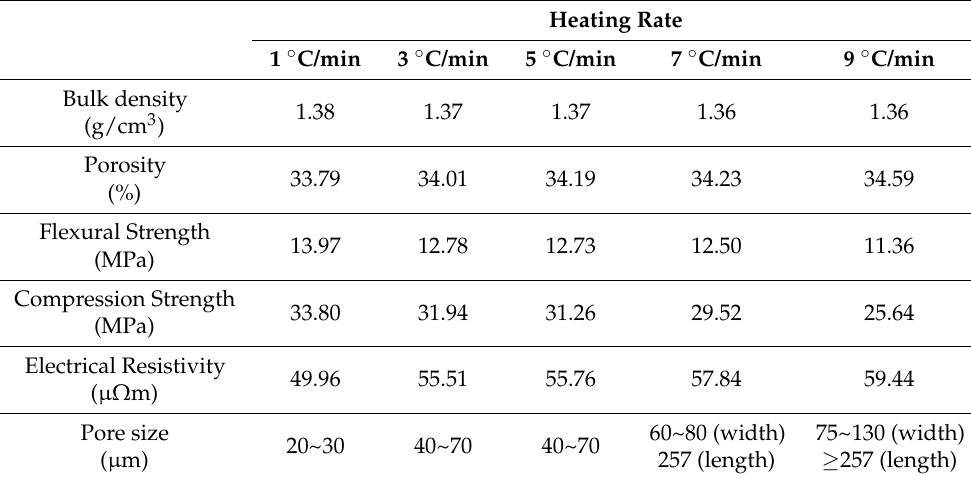
Table 2. Properties of graphite blocks as functions of heating